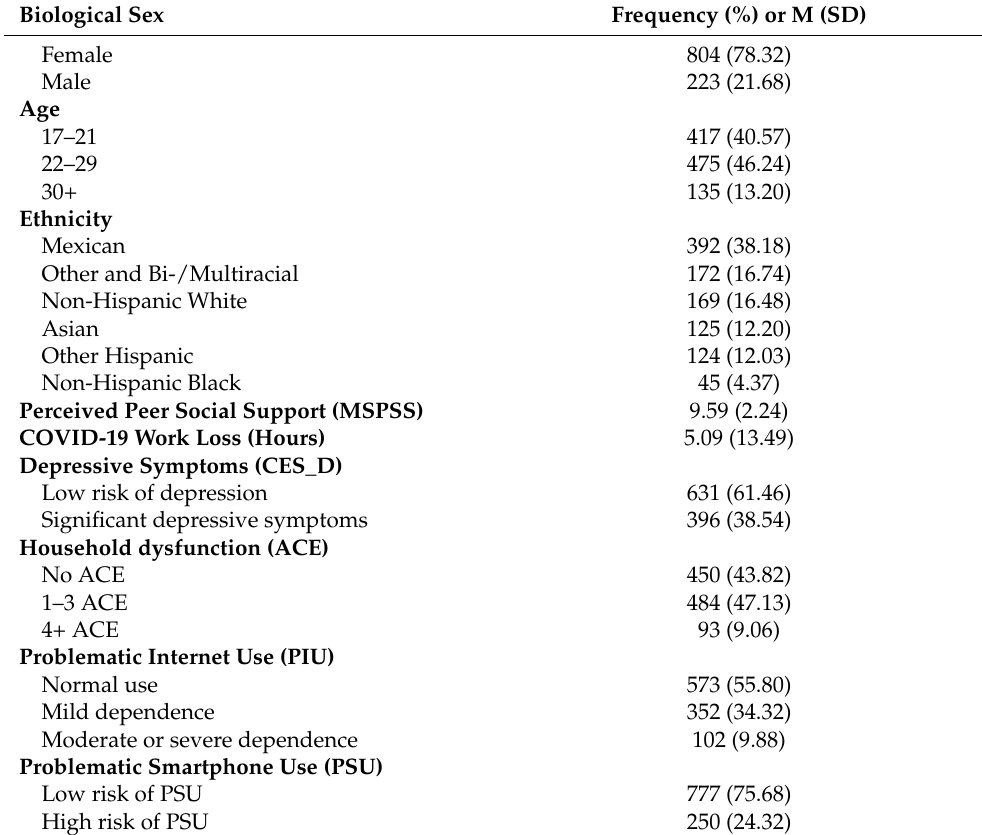
Table 2. Sample characteristics ( N =